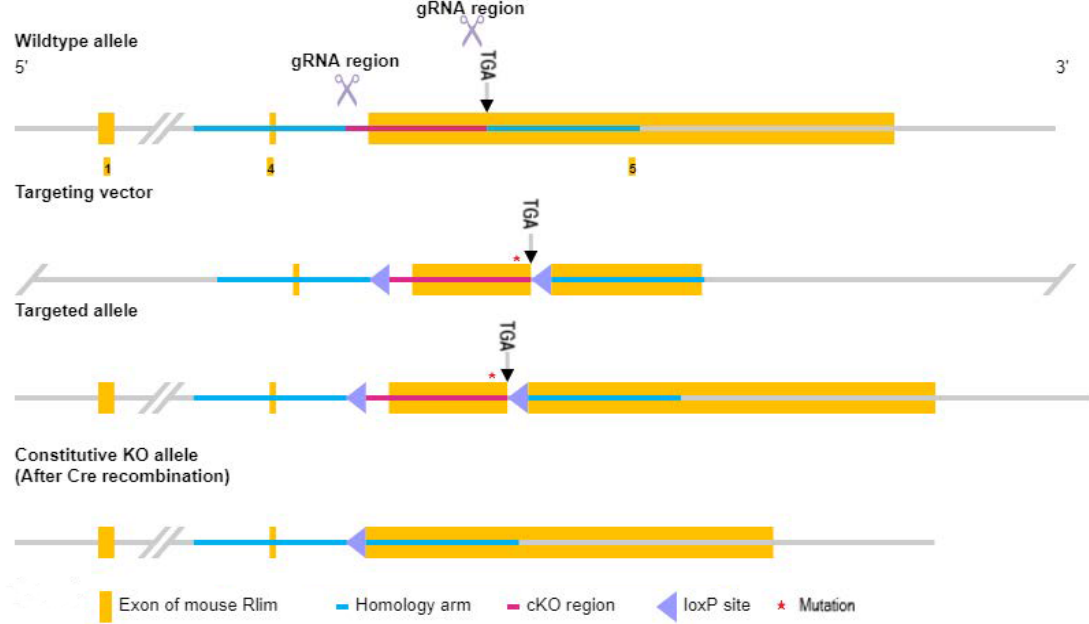
Figure 2. Schematic diagram of the strategy for knockout of the Rlim gene. Two sgRNAs were designed to direct the Cas9 enzyme to cut the wild-type Rlim allele and facilitate homologous recombination with the targeting vector. TGA is the stop codon site of the Rlim gene. A synonymous mutation was introduced into the targeting vector to avoid sgRNA-mediated cleavage of the targeting vector or the successfully targeted allele.